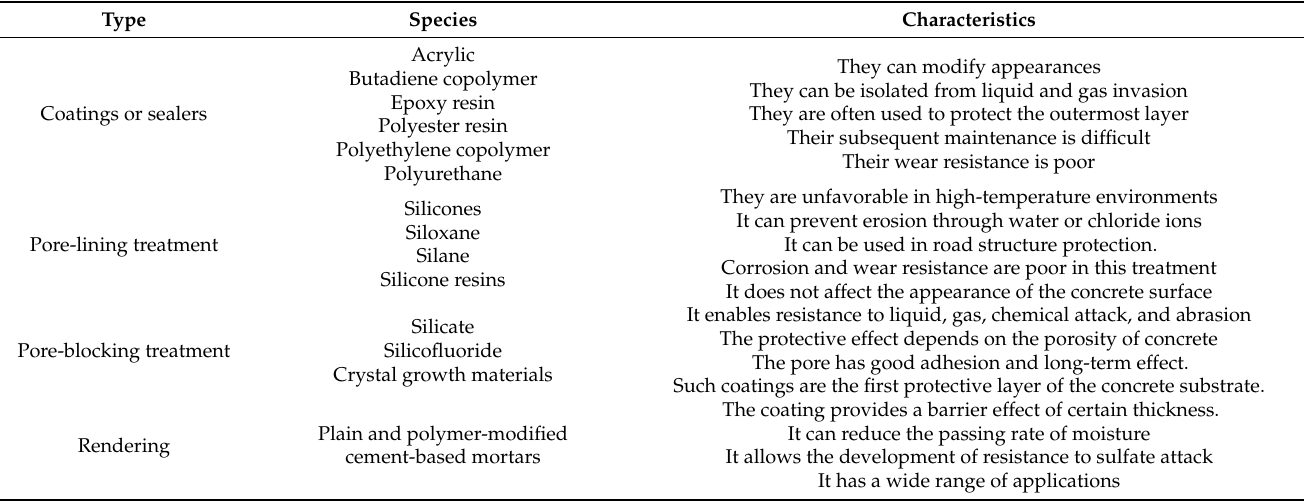
Table 2. Coating material with common mechanisms